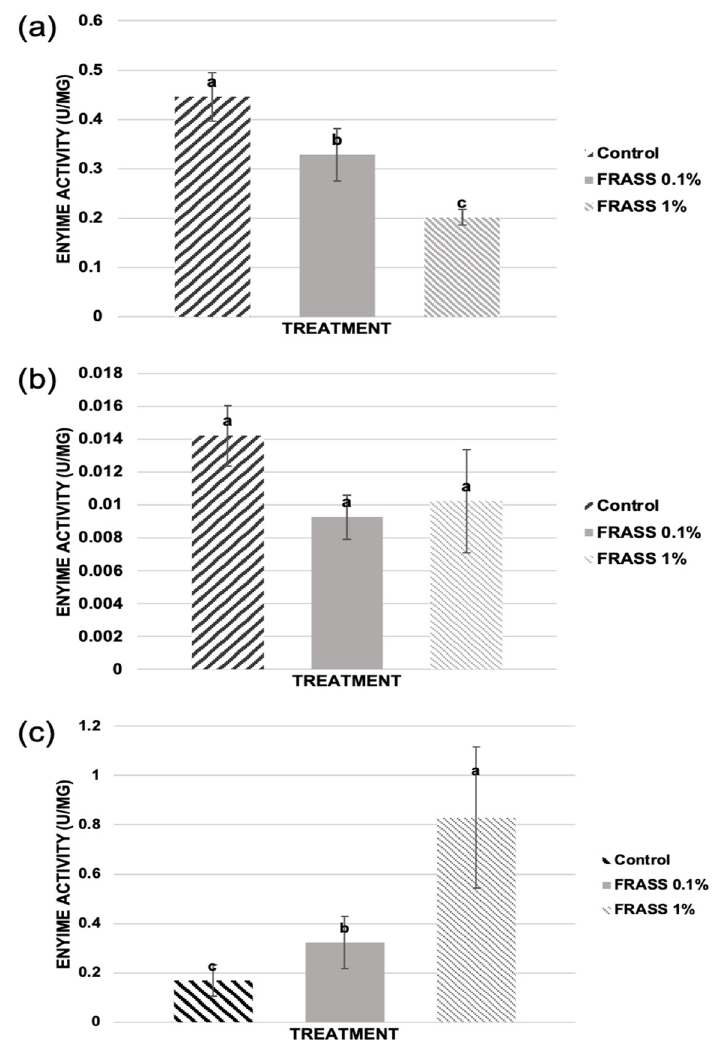
Figure 2. Effect of cricket frass on the ( a ) PAL, ( b ) SOD and ( c ) CAT enzyme activities in tomato plants. Different letters in each histogram for each enzyme indicate a statistically significant difference after two-way ANOVA ( p < 0.05) and Tukey’s HDS test for multiple comparisons (95%). Error bars represent the standard deviation of the mean.